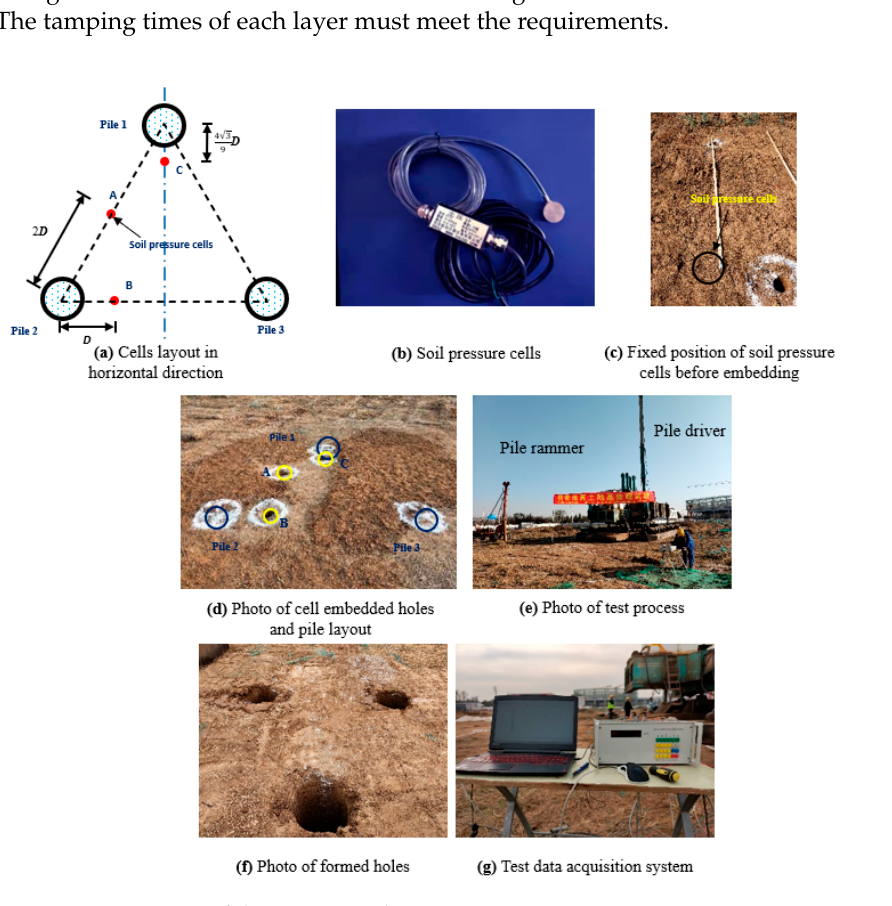
Figure 3. In situ tests of the SP − PSC pile group in Xianyang.